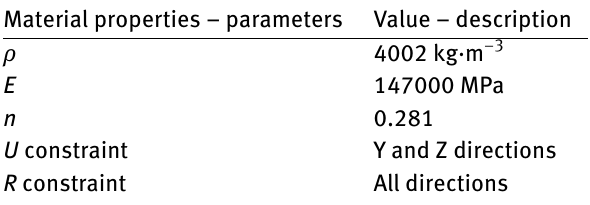
Table 3: Material model and geometrical constraint of the